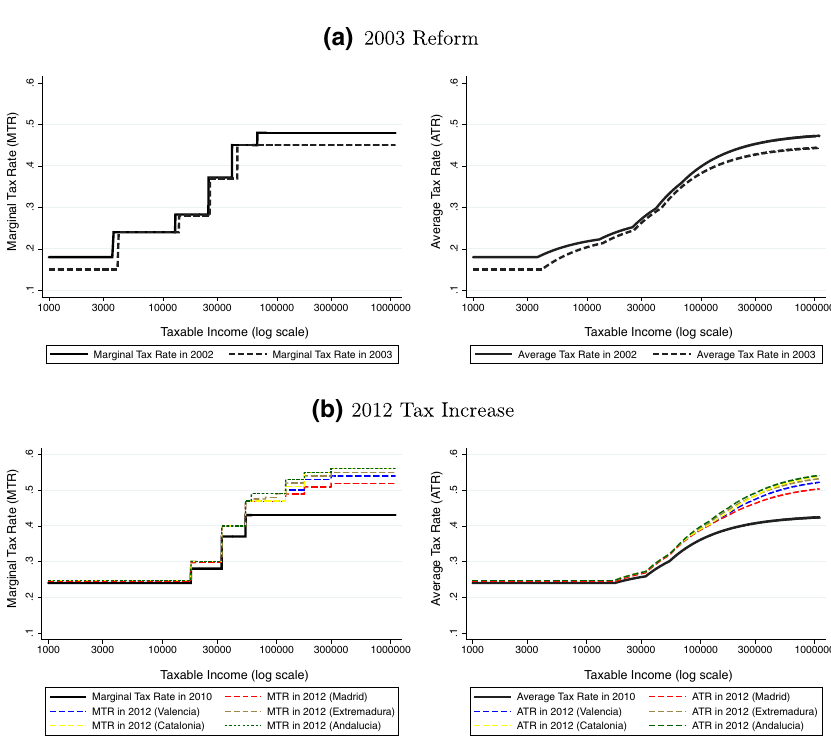
Fig.1 Tax reforms. Notes: The top panels depict the income tax schedule on the general tax base before and afterthe2003reform,whichreducedthemarginaltaxrate(MTR)atthebottomandtopofthetaxableincome distribution (top-left panel), leaving the middle brackets almost unaffected and resulting in a reduction in the average tax rate (ATR) for all income levels (top-right panel). The bottom panels depict the tax schedule on the general tax base before and after the 2012 reform, which increased the marginal and average tax rates for all income levels, with a larger increase for higher incomes. We use a log scale for base year in the horizontal axis for comparability with Fig.